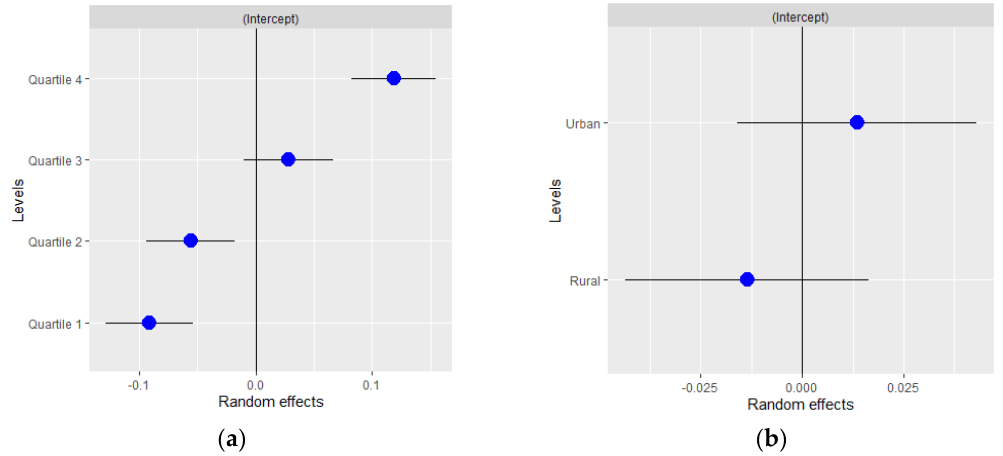
Figure 2. Random effects by ( a ) basic healthcare area deprivation and ( b ) by type of area in men for all the period analyzed.